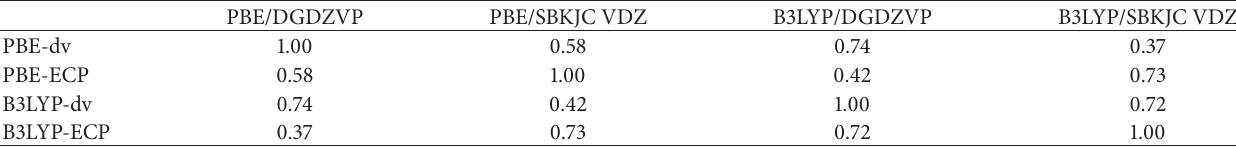
Table 8: Correlation of 𝐽 -coupling within the